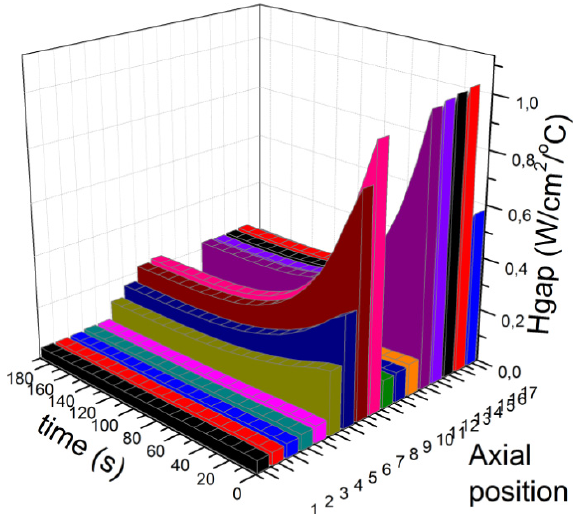
Fig. 17. H gap pro fi le evolutions during ULOF/PP accident for one sub-assembly from the inner core.